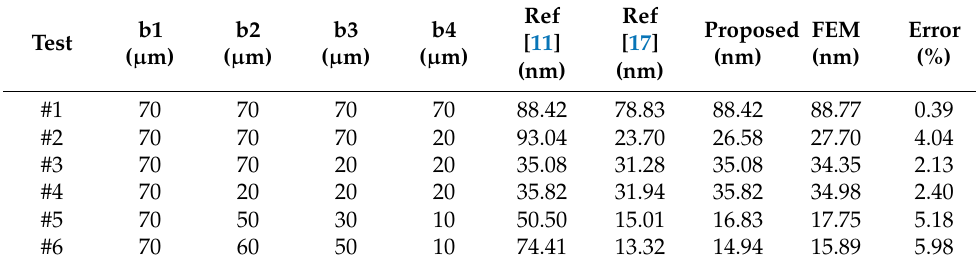
Table 5. Comparison of tip displacement of predecessor’s model and newly proposed model.